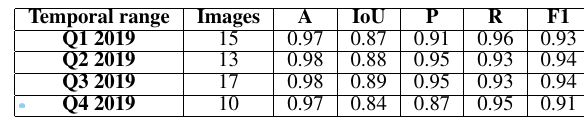
Table 4. Metrics of the HSV approach with a time range of three months (Sentinel-2).